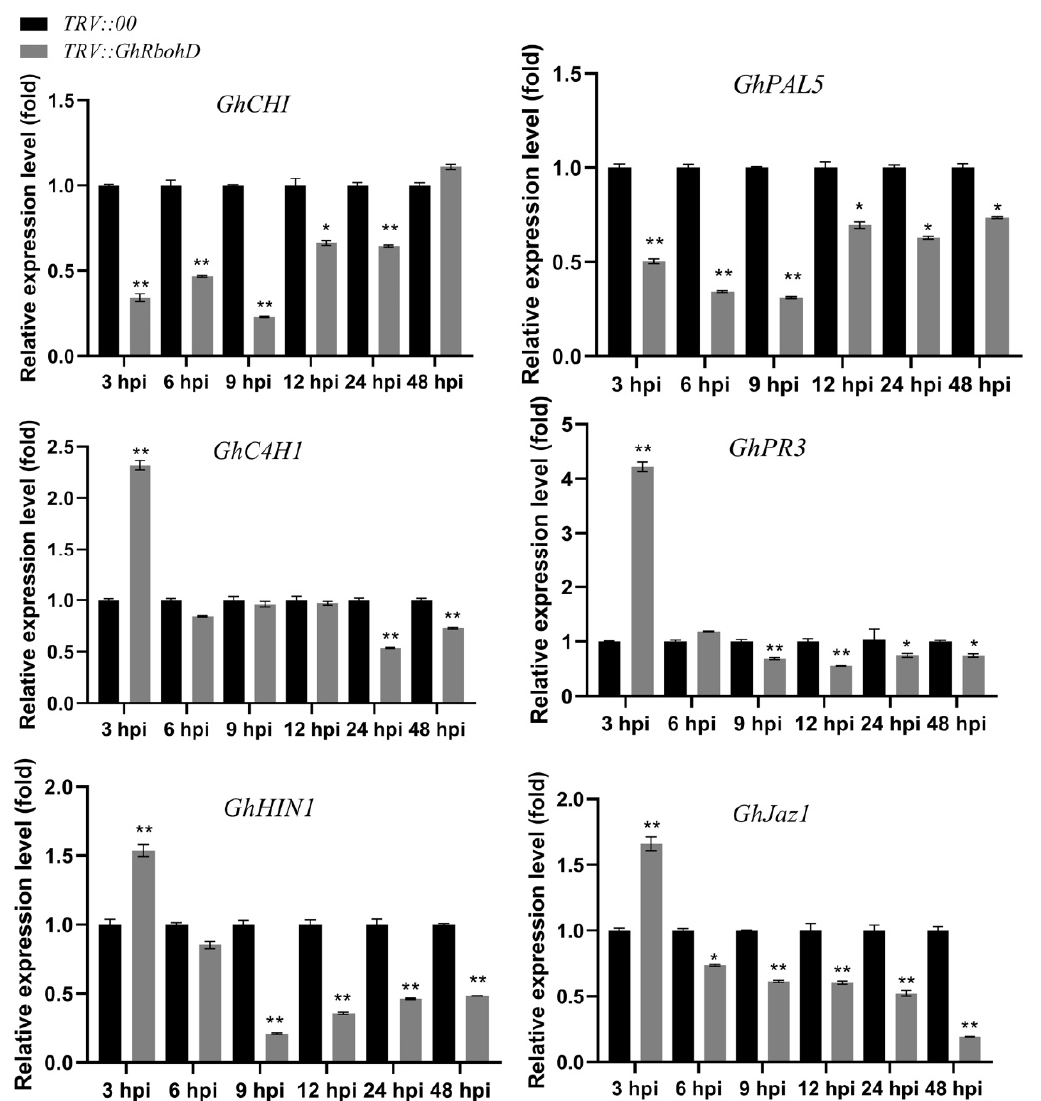
Figure 5. Expression of disease-resistant genes in GhRbohD silencing and control plants. Error bars represent the standard deviation of three biological replicates. Asterisks indicate statistically significant differences, as determined by Student’s t -test (* p < 0.05; ** p <